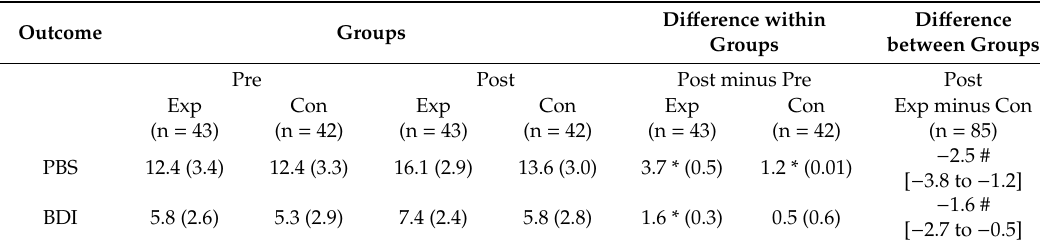
Table 2. Mean (SD) for Outcome at all study visits for each group, mean (SD) di ff erence within groups, and mean (95% CI) di ff erence between